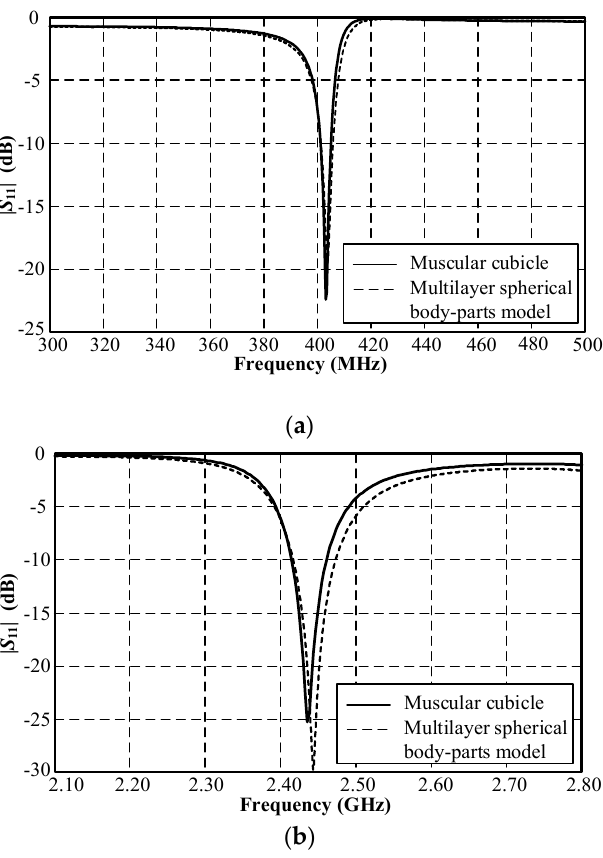
Figure 9. Comparison between the simulated | S 11 | of the MICS/ISM meander-line microstrip antenna encapsulated in a glass pod inside the muscular cubicle and in the multilayer spherical body-parts model: ( a ) MICS and ( b ) ISM bands.